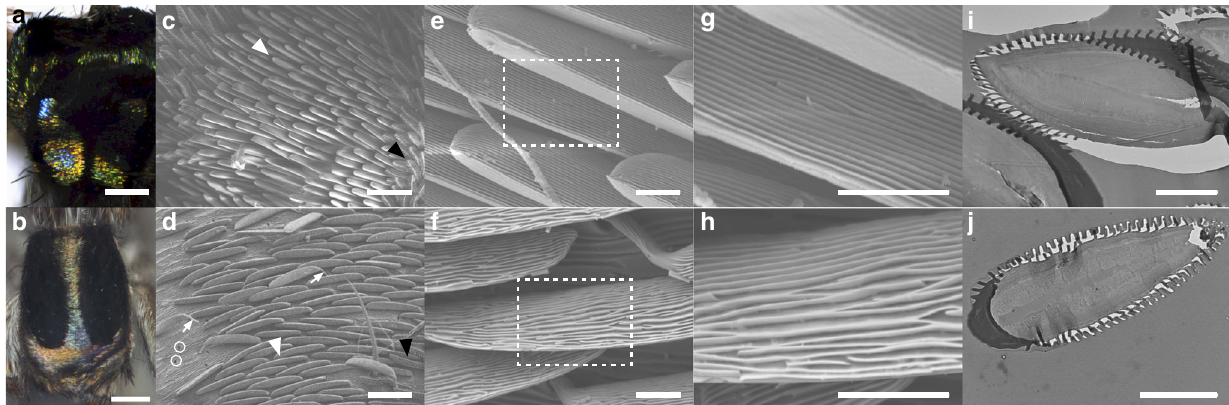
Fig. 2 Optical and electron micrographs for the abdominal scales of M. robinsoni and M. chrysomelas . a , b Optical micrographs of the abdominal scales of M. robinsoni ( a ) and M. chrysomelas ( b ), showing two types of scales, iridescent and black. c , d SEM micrographs for the abdominal scales of M. robinsoni ( c ) and M. chrysomelas ( d ). At the centre of the image are the iridescent scales (white arrowhead). Black scales can be seen on both sides of the image (black arrowhead). The stems (white arrows) and the sockets (white circles) of detached scales can be observed. e – h Zoom-in views of SEM micrographs of the iridescent scales of M. robinsoni ( e , g ) and M. chrysomelas ( f , h ) showing grating structures. The grating period for the iridescent scales of M. robinsoni is more regular than that of M. chrysomelas . i , j TEM micrographs revealing the airfoil-shaped pro fi les and the surface nanogratings in the iridescent scales of M. robinsoni ( i ) and M. chrysomelas ( j ). Scale bar: a , b 200 μ m; c , d 20 μ m; e – j 5 μ m